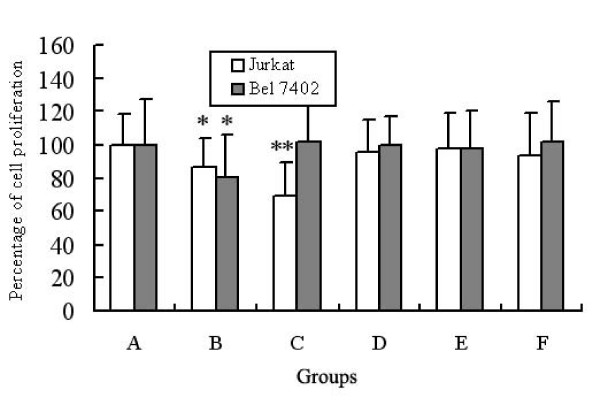
The effects of AFP on the co-cultured cells. Bel 7402 and Jurkat cells were co-cultured for 24 h following treated with AFP (20 mg/L) (C), AFP (20 mg/L) plus anti-AFP antibody (40 mg/L) (D), anti-AFP antibody (40 mg/L) (E) and HSA (20 gm/L) (F) respectively. Graph bar A represents the viability of separate-cultured cells. Graph bar B represents co-cultured and no-treatment group. After 60 h, two cell lines were separated and the viability of each cell was observed respectively. *P < 0.05 and **P < 0.01 vs corresponding to normal control (0 mg/L) analyzed by t-test. Data were representative of an experiment that was repeated three times presented as mean ± SD of 12 samples.